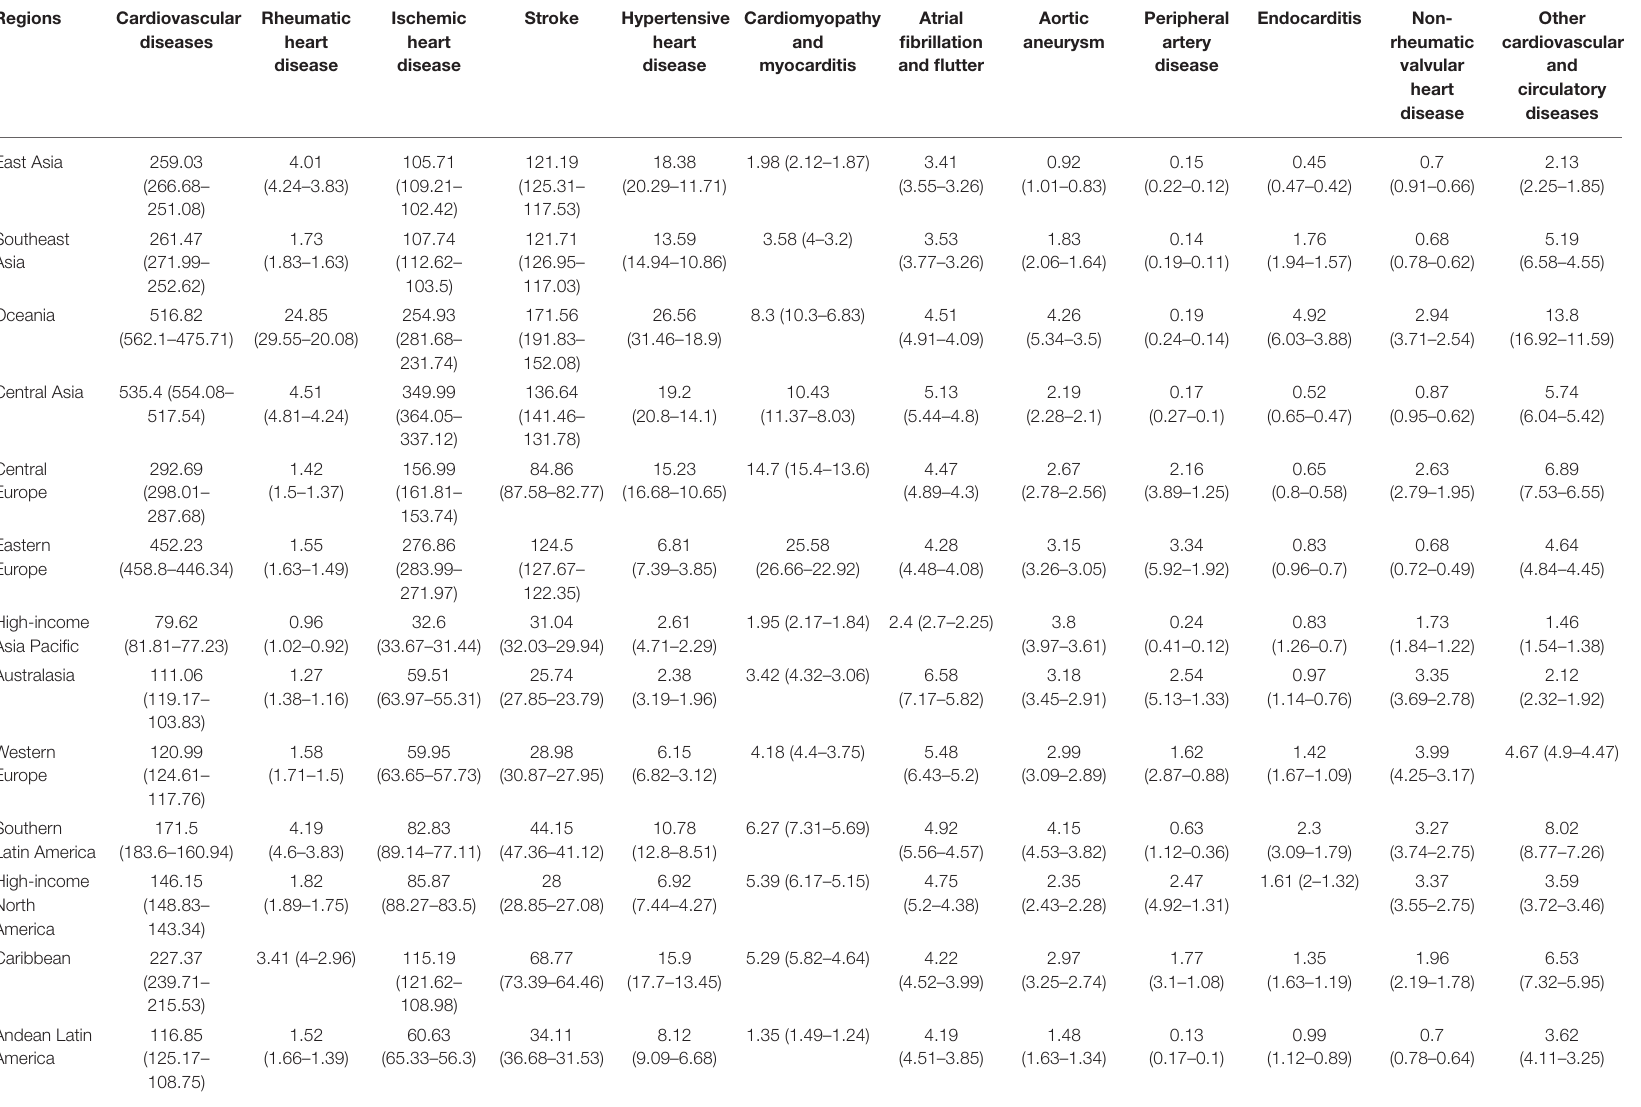
TABLE 2 | The age standardized of death of CVD and its 11 categories for different regions in 2017.